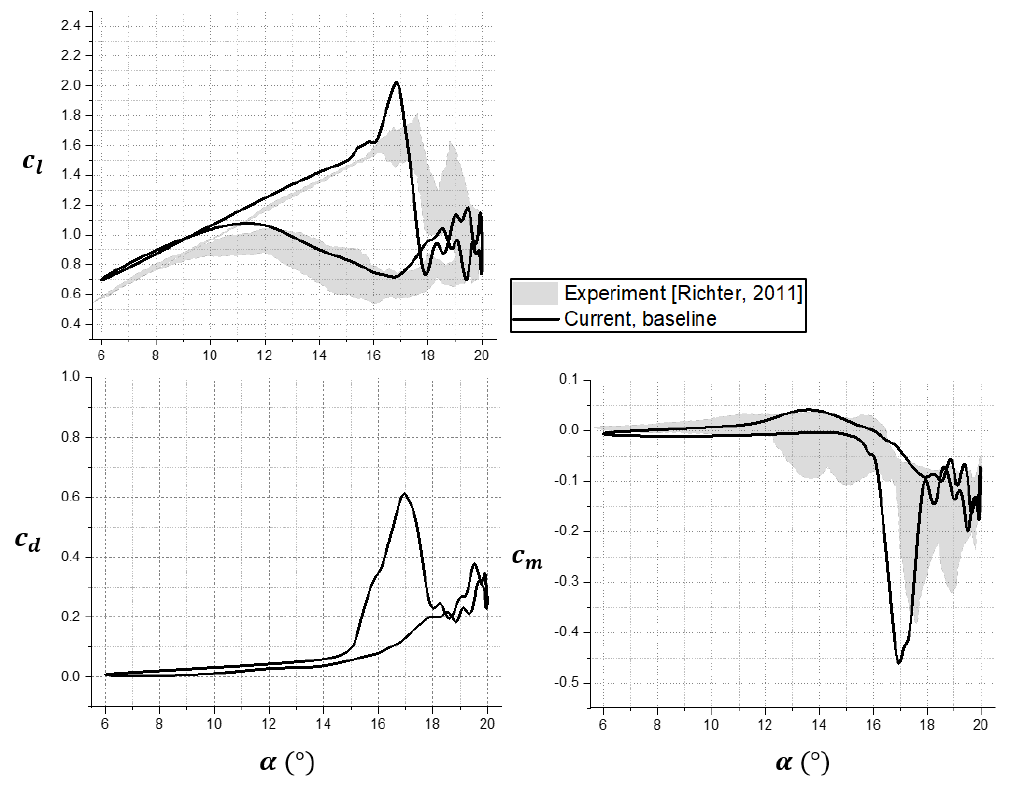
Figure 13. Pitching OA209 airfoil in the test [38] and current simulations. Ma = 0.3, Re = 1.15 M, k = 0.05 and α = 13 ◦ ± 7 ◦ .